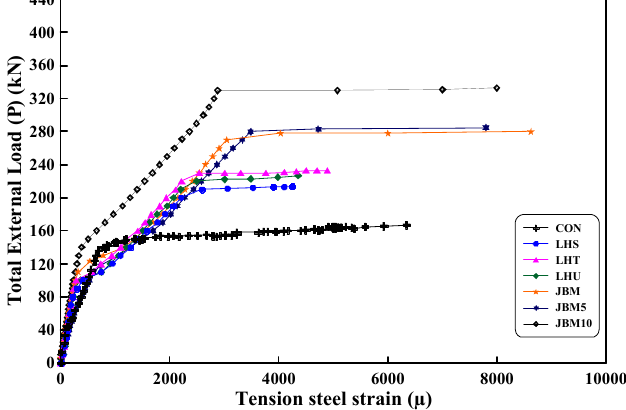
Figure 6. Load–strain curves: Tension steel.